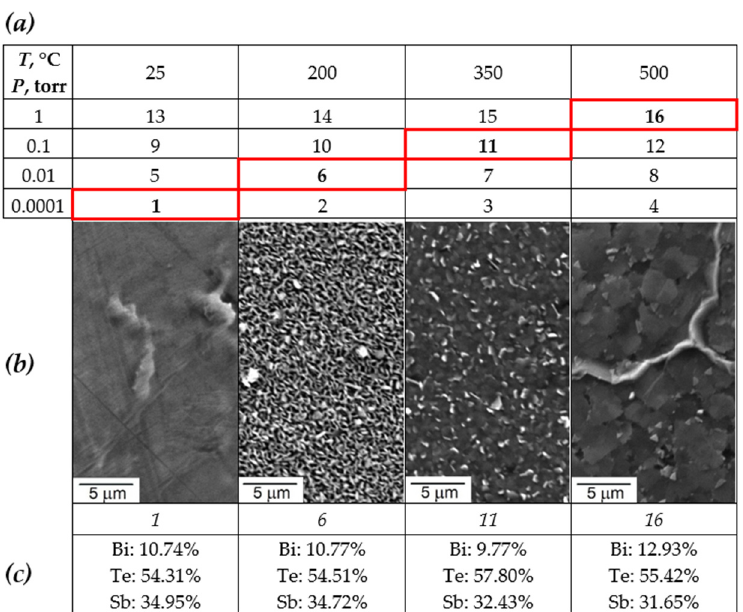
Figure 3. The results of the study of the microstructure of thin films: ( a ) the plan of the experiment where the red borders of the cell indicate the samples selected for analysis; ( b ) images of the microstructure of the samples. ( c ) EDS results for selected samples.